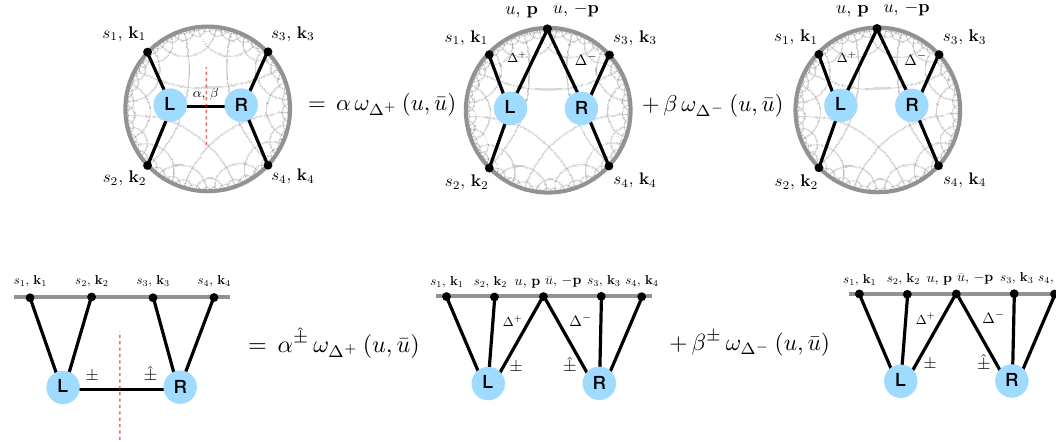
Figure 9. Upon taking the discontinuity (2.33) of an internal line, diagrams contributing to boundary correlators in (EA)dS decompose into a linear combination factorised contributions, one for the exchanged ∆ + mode and the other for the exchanged ∆ − mode, which are each given by a product of the two on-shell sub-diagrams to the left and the right of the cut as shown above. In the dS case this factorisation is at the level of each in-in contribution. In the examples below this illustrated for four-point tree-level exchange diagrams. In section 5 we give some examples of loop